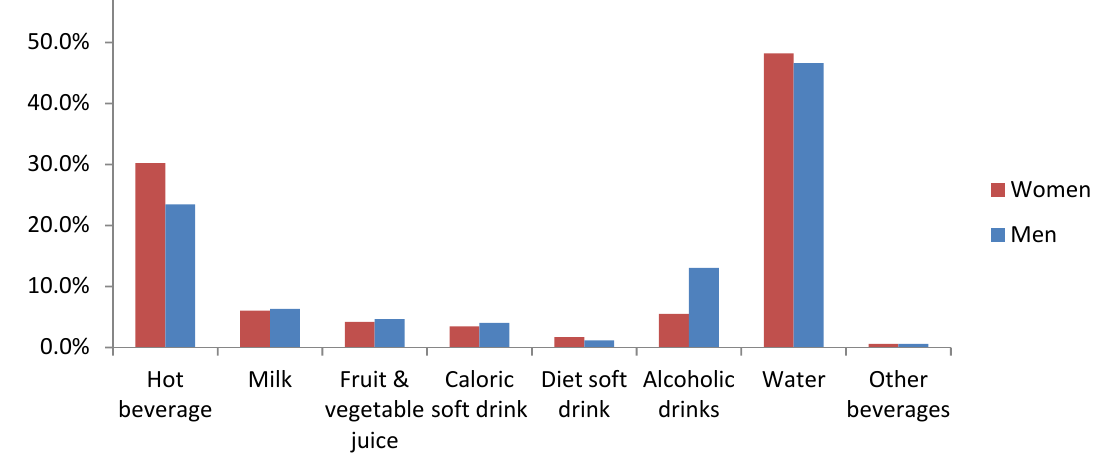
NS: Not significant; SE: standard error. Water represented almost half of the beverage consumption over 3 days period for both men and women (48.2% for women and 46.6% for men) (Figure 2). The second most popular beverage was hot beverages (respectively 30.2% and 23.5% for women and men). Alcohol was in the third position for men (13.1%) and fourth position for women (5.5%).